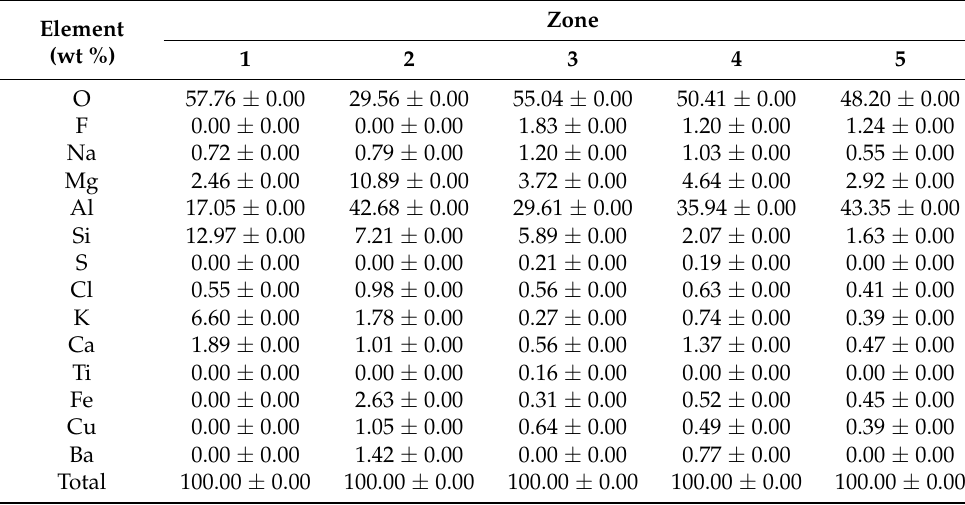
Table 6. EDS microanalysis (wt %) of the areas marked in Figure 5c (PVL